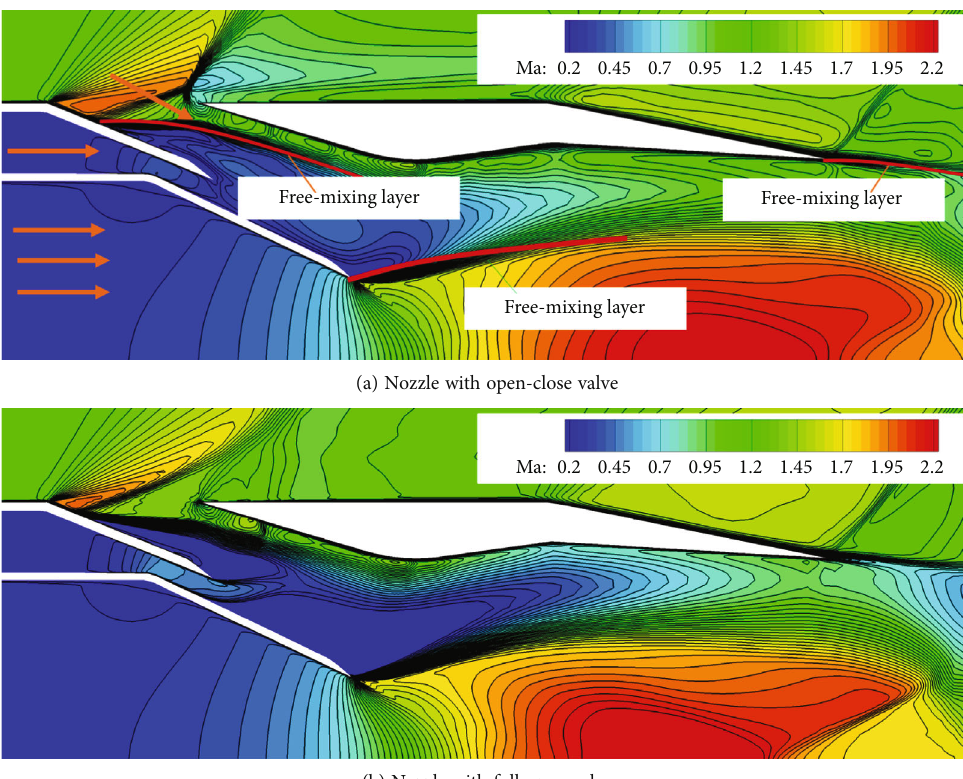
Figure 7: Mach contours of the symmetry plane of the ejector nozzles.